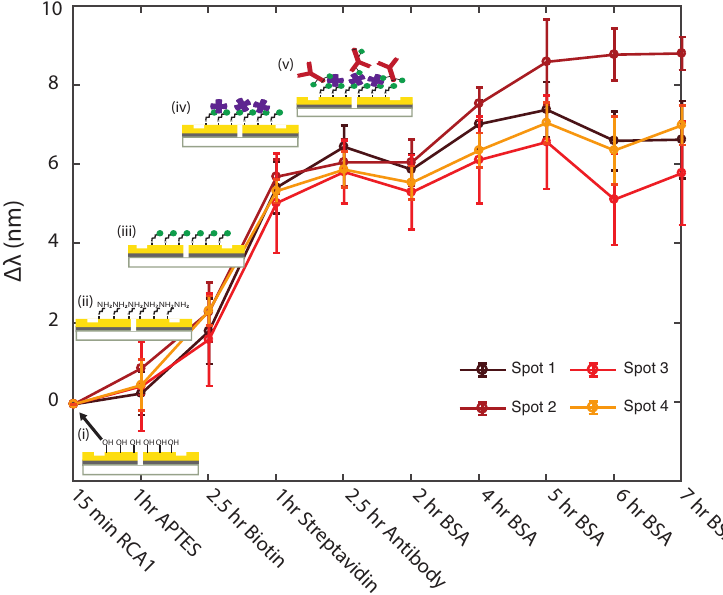
Figure 4. Uniformity study of surface functionalization steps across four sensing spots. Circles represent the mean value of wavelength shift ( ∆ λ ) measured from 7 GSG plasmonic interferom- eters after each functionalization step, labelled in the horizontal axis. Error bars represent the standard deviation. Lines and symbols with different colors indicate data measured from different sensing